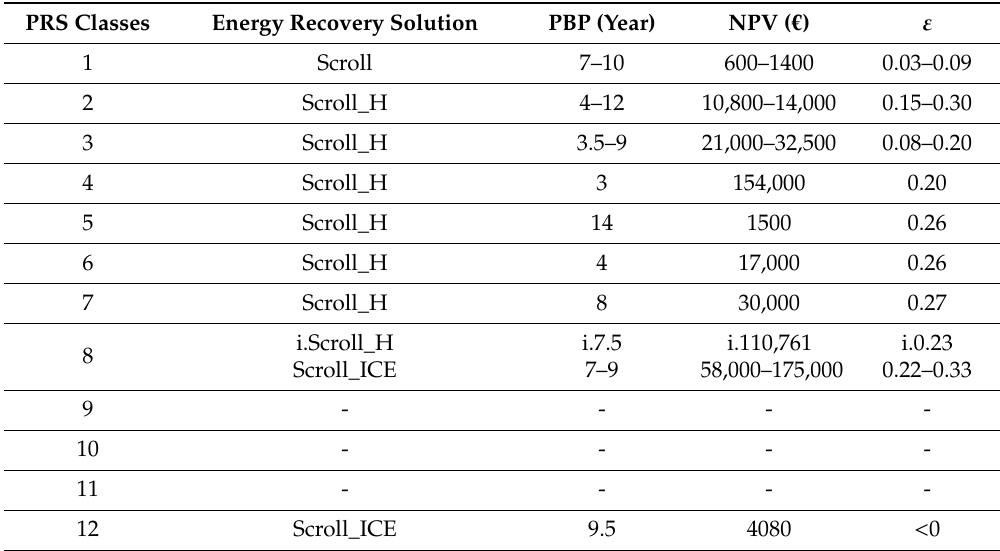
Table 5. Dominating energy recovery solutions for each PRS class.